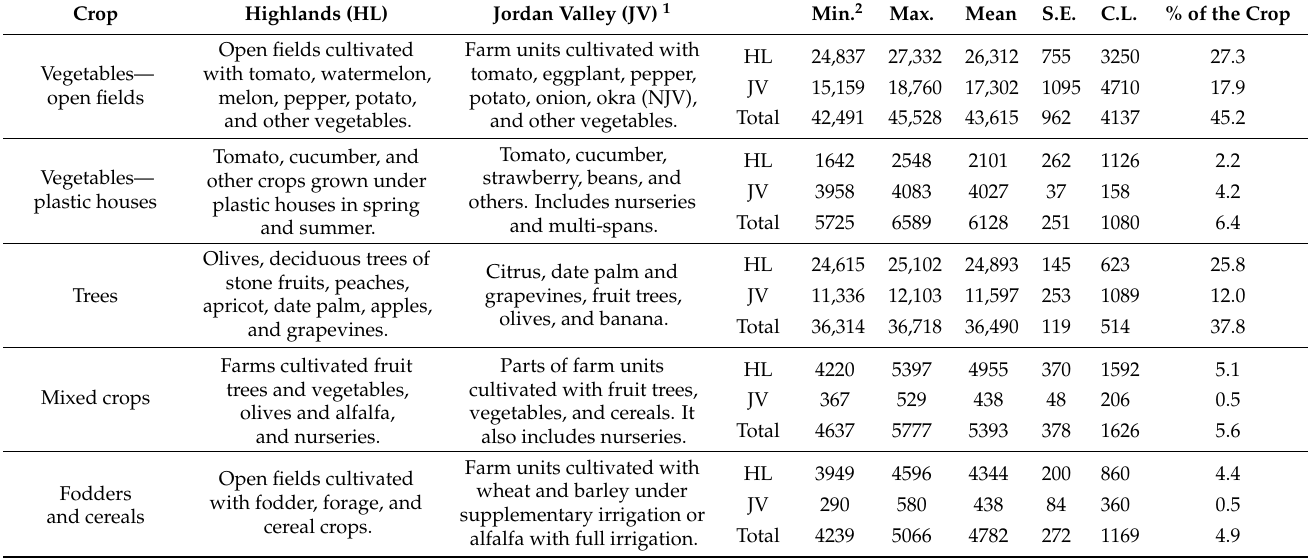
Table 2. Summary of area (ha) for irrigated crops in Jordan during